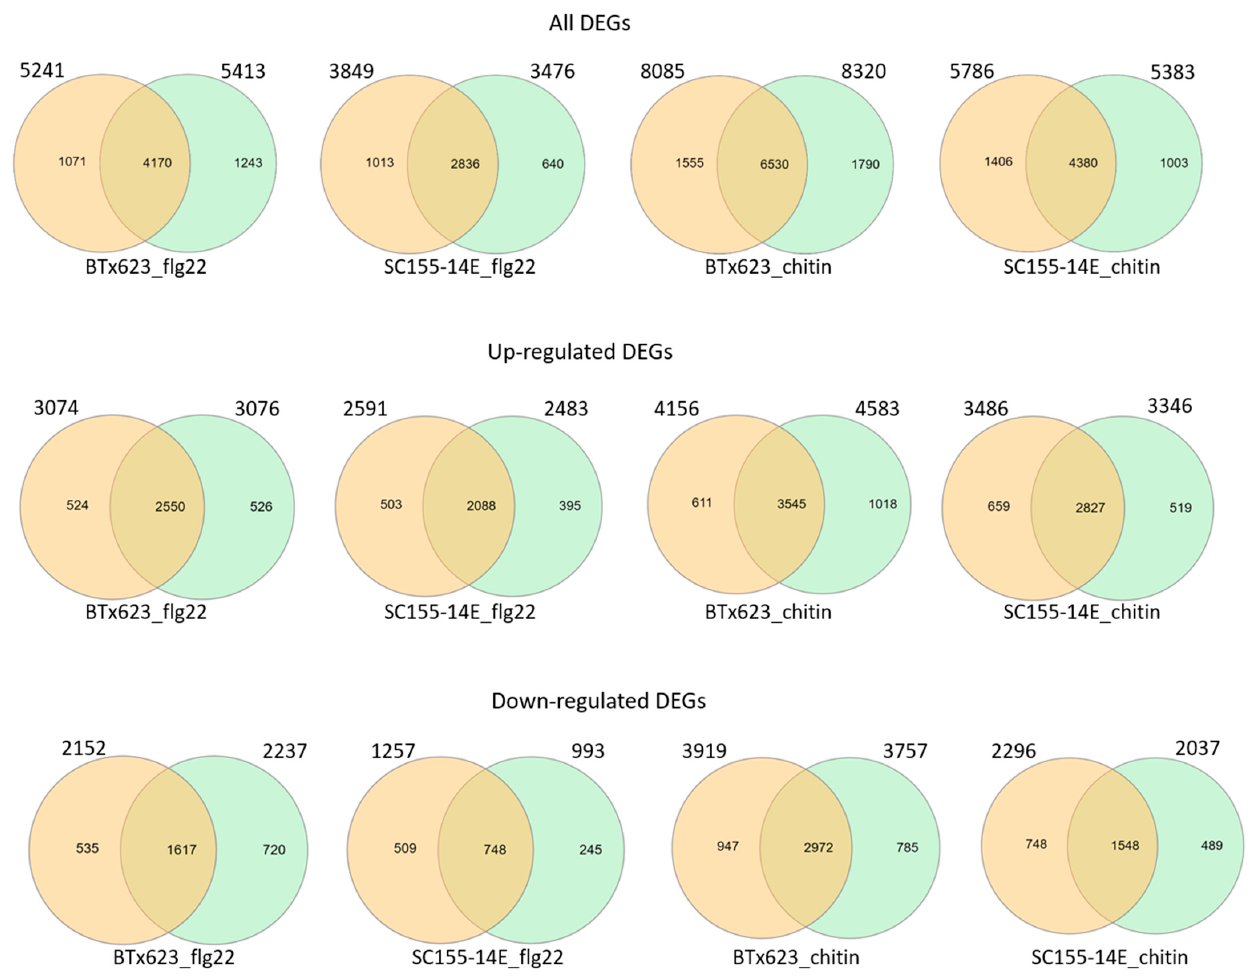
Figure 5. Venn diagrams showing the pairwise overlap of total, up- and down-regulated DEGs selected using pipeline #1 and pipeline #2 of the genotypes and treatments as marked in figures. The circles and numbers on the left of each pair represent DEGs selected using pipeline 1 and the circles and numbers on the right of each pair represent DEGs selected using pipeline